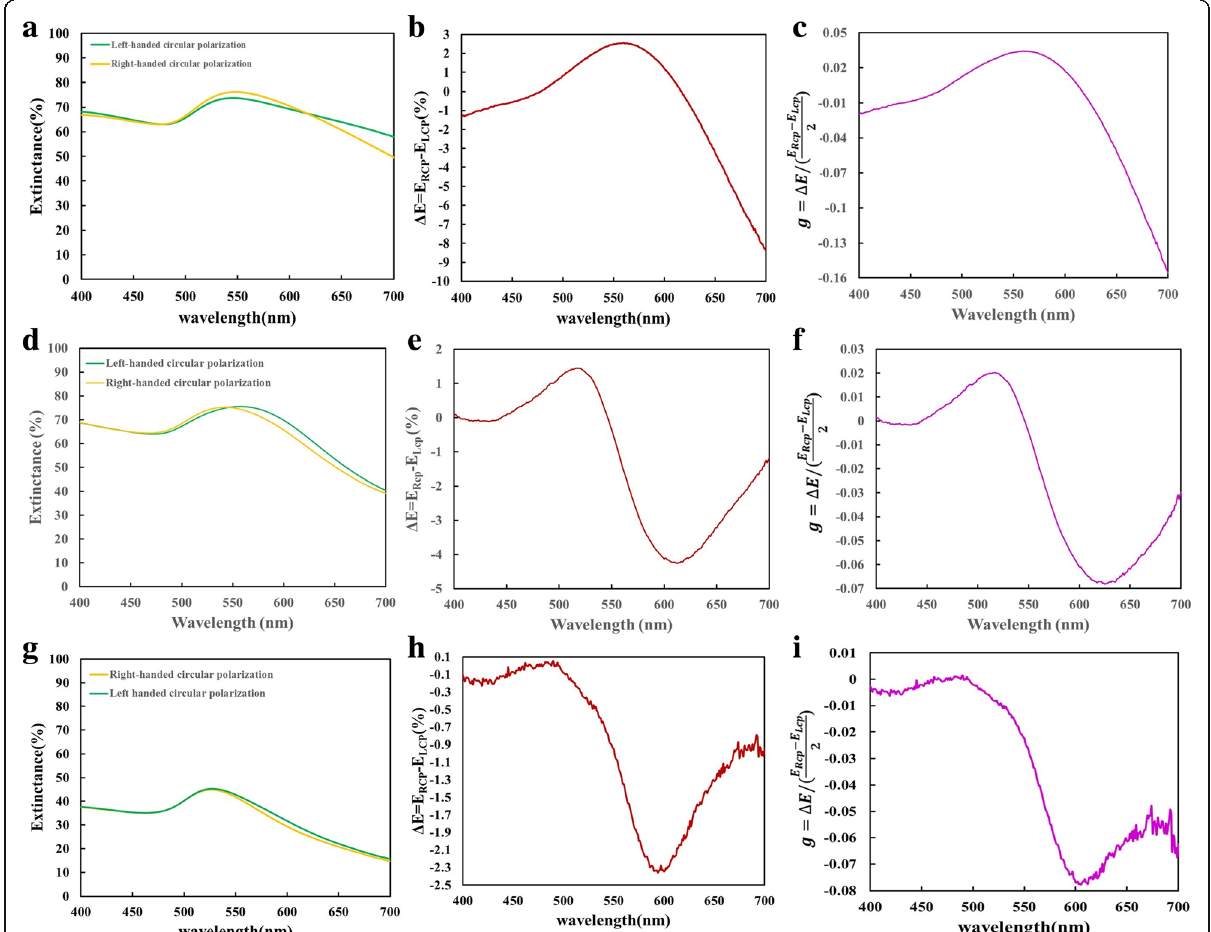
Fig. 6 Experimental extinctance, extinctance difference ( Δ E ), and the g-factor spectra of sample 1 ( a – c ), sample 2 ( d – f ), and sample 3 ( g – i